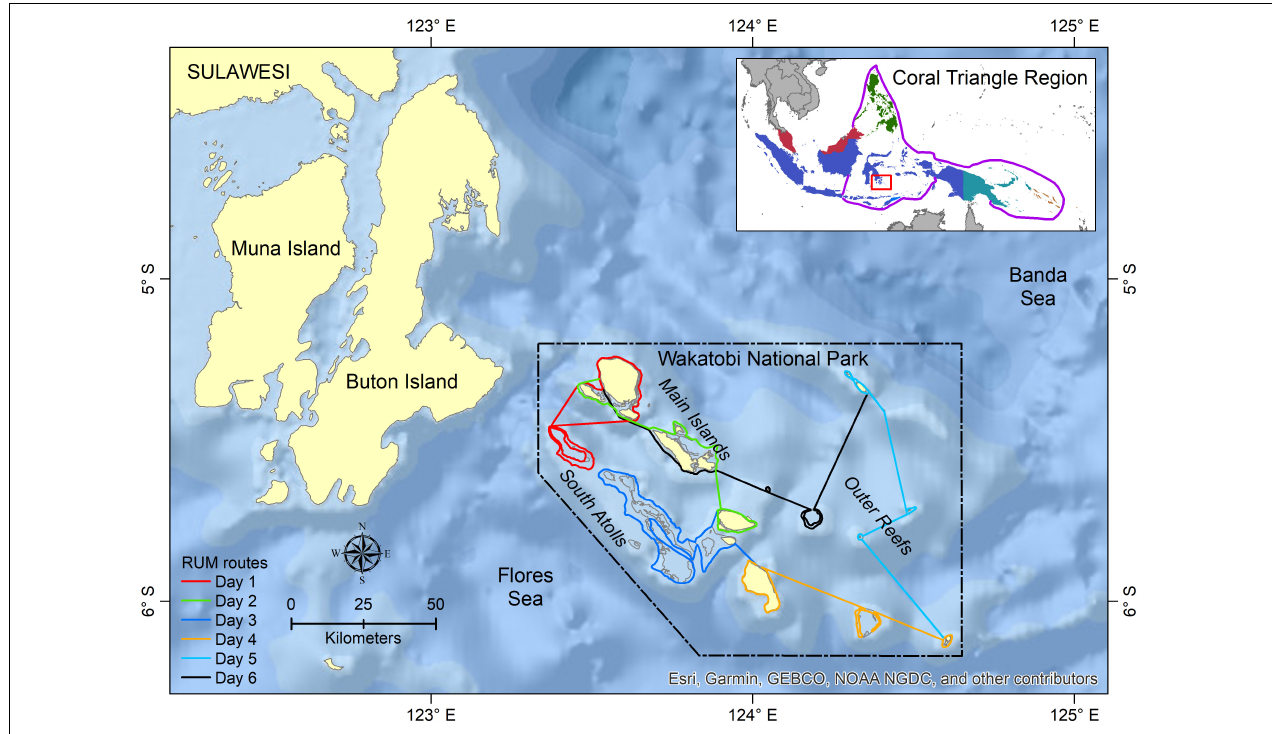
FIGURE 1 | Study area in Wakatobi National Park (WNP) and adjacent waters. The routes of Resource Use Monitoring (RUM) as a main platform-of-opportunity survey are presented as colored lines.